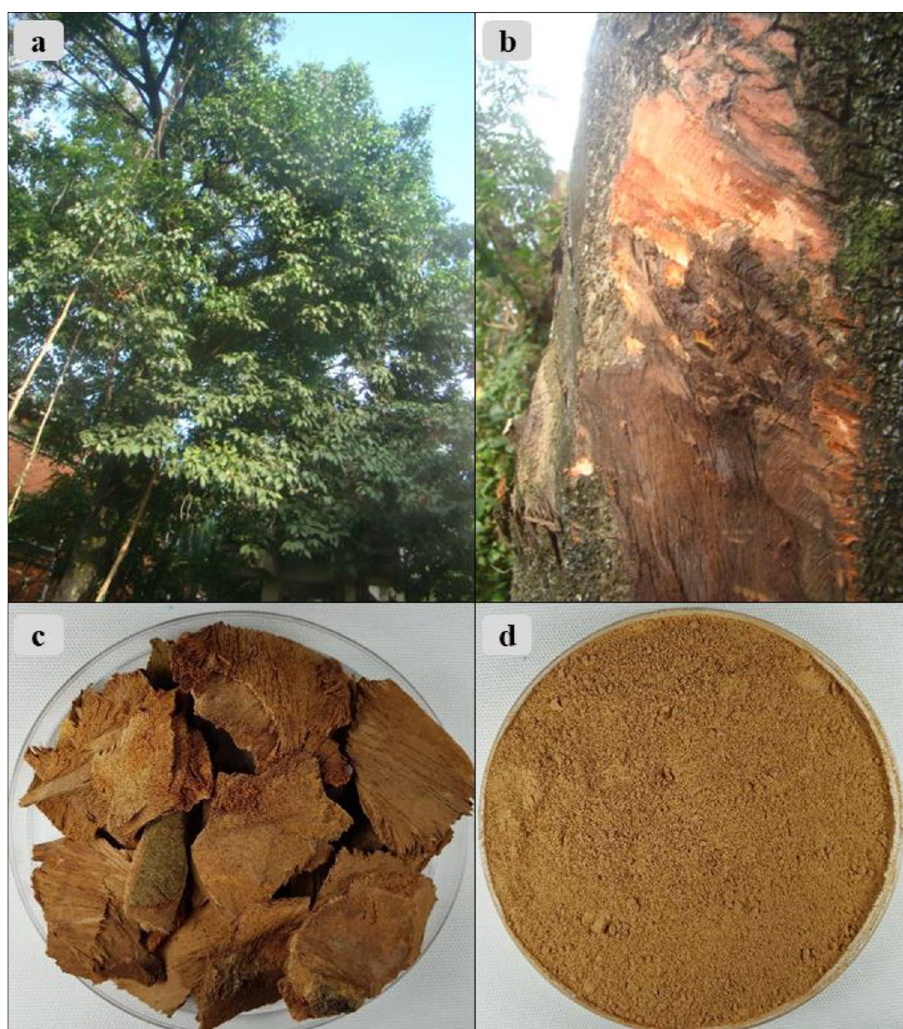
Figure 1. Prunus africana medicinal plant. ( a ) P. africana tree. ( b ) Stem of P. africana with part of its bark harvested for medicine purpose . ( c ) Harvested and dried P. africana stem bark. ( d ) Pulverized P. africana stem